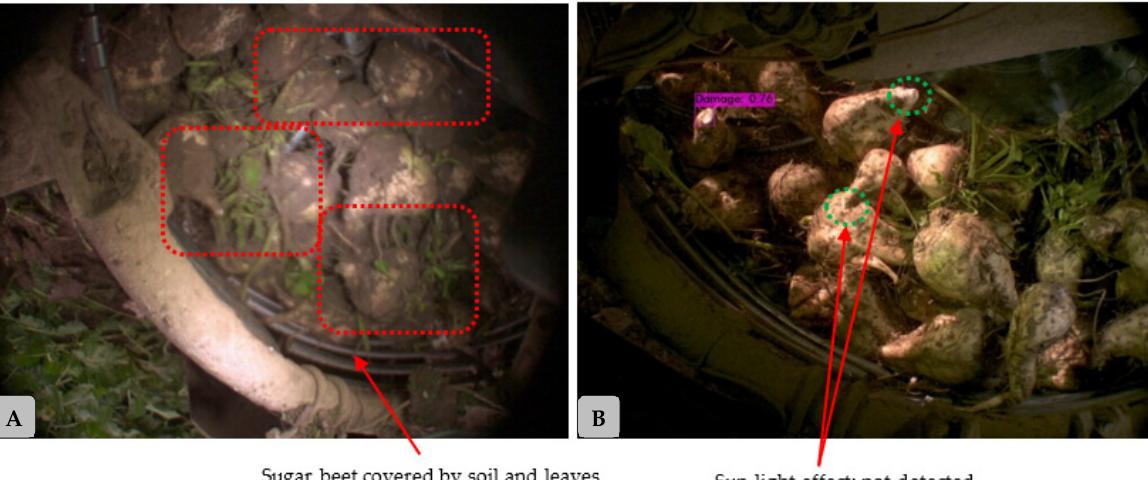
Figure 9. Examples of images affecting detection performance; covered by soil ( A ) and sun light effect ( B ).